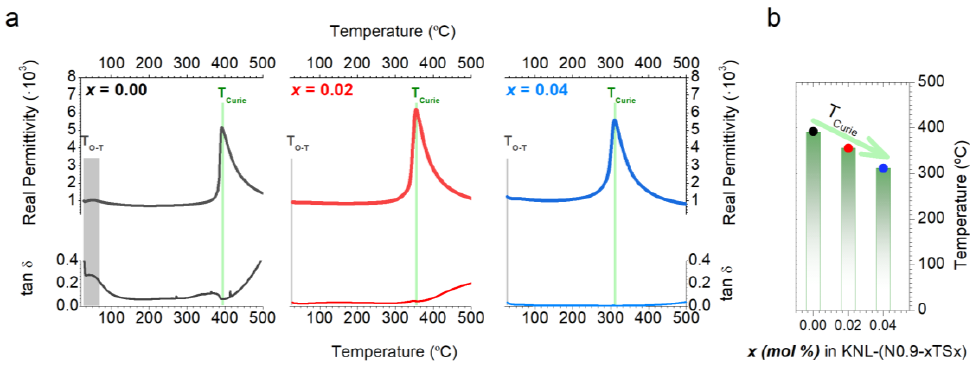
Figure 5. ( a ) Dielectric permittivity and dielectric loss (tan δ) vs. temperature, at 10 kHz, of KNL − (N 0.9 − x TS x ) ceramics with different Sb contents sintered at 1125 °C. ( b ) Curie temperature value KNL − (N 0.9 − x TS x ) ceramics with different Sb contents sintered at 1125 ◦ C. ( b ) Curie temperature (Tc) of the KNL − (N 0.9 − x TS x )ceramics decreases with Sb addition. value (Tc) of the KNL − (N 0.9 − x TS x )ceramics decreases with Sb